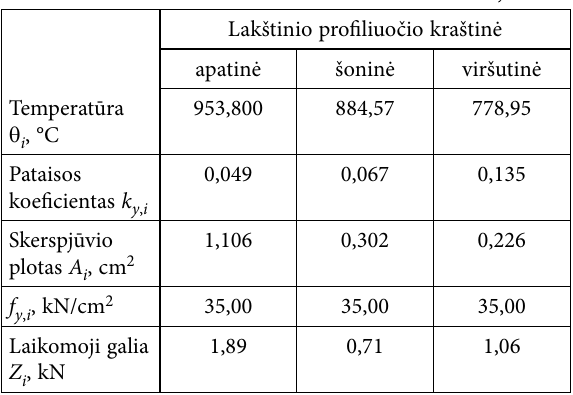
Table 8. Calculations with the reduction factor k